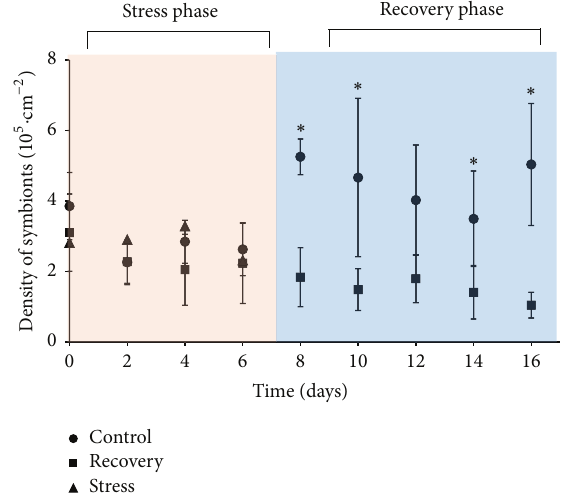
Figure 5: Photosynthetic efficiencies as quantum yield ( 𝐹 𝑉 /𝐹 𝑀 ) measured by PAM fluorometry of Pocillopora damicornis corals ( 𝑛 = 3 ) in control (26 ∘ C); recovery treatment (ramping from 26 ∘ C at day 0 to 32 ∘ C at day 6 then cooling to 26 ∘ at day 9); and stress treatment (ramping from 26 ∘ C at day 0 to 32 ∘ C at day 6 and then stable at 32 ∘ C until day 16) during 16 days. Asterisks ( ∗ ) stand for a significant difference ( 𝑝 ≤ 0.05 ).